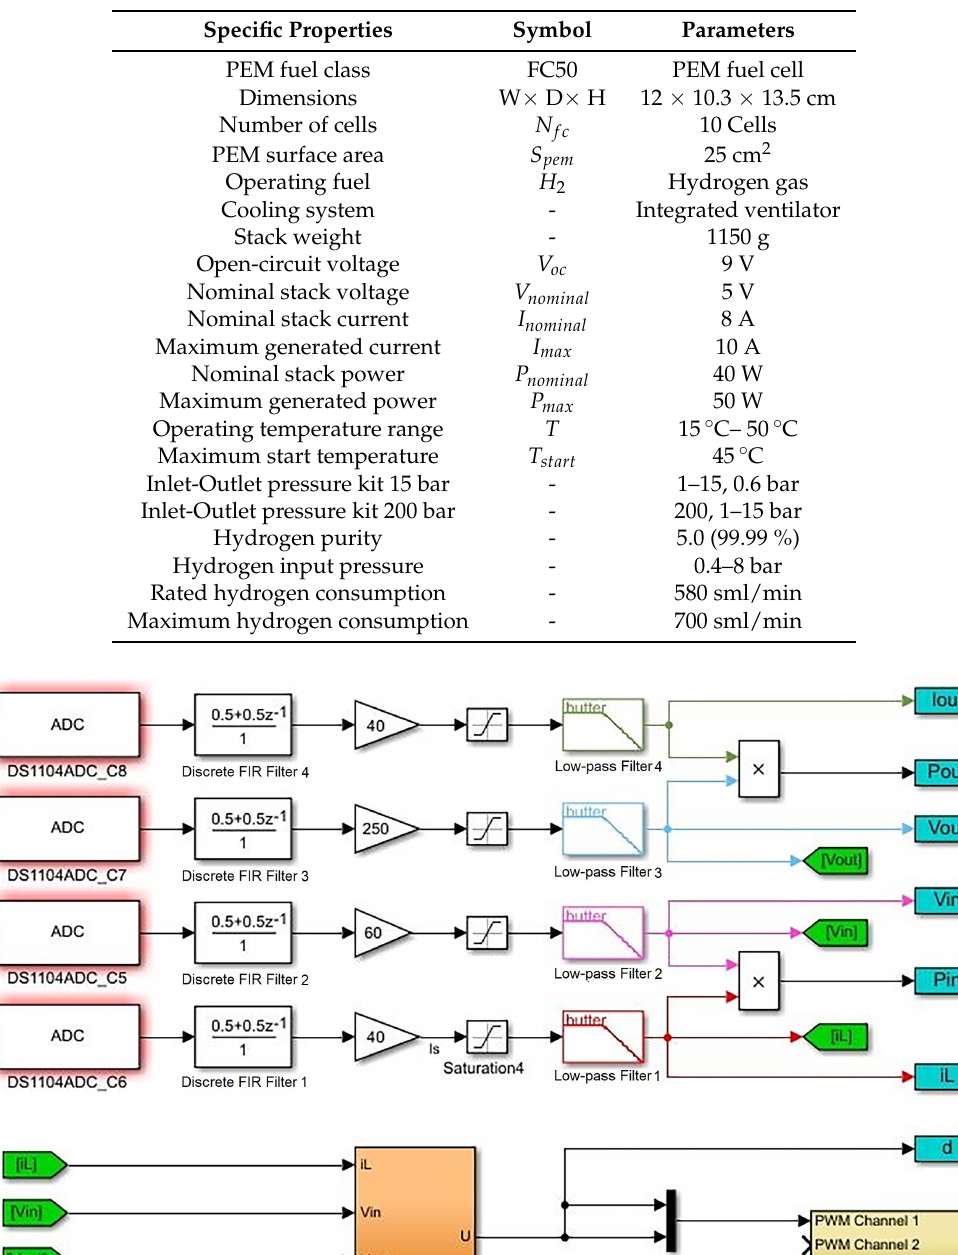
Table 1. FC50 fuel cell stack technical data.